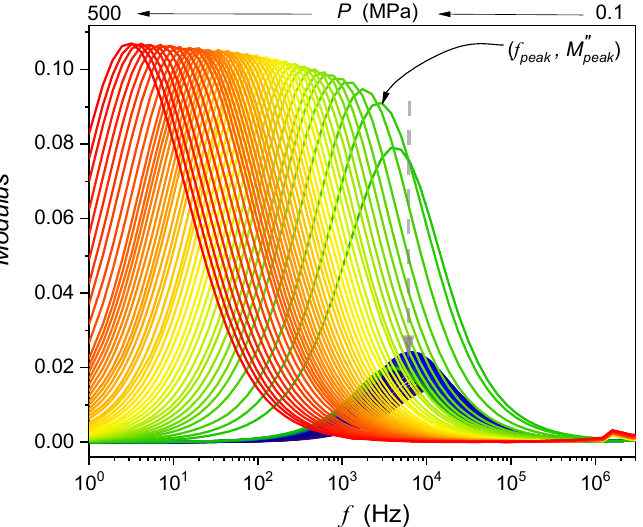
Figure 2. Dielectric modulus loss curves in nitrobenzene, on compressing from the liquid phase under atmospheric pressure up to P = 0.5 GPa, for isothermal tests at T = 308.2 K. The arrow indicates the melting pressure: the liquid phase is in deep blue, and the solid is in green, yellow, orange, and red.